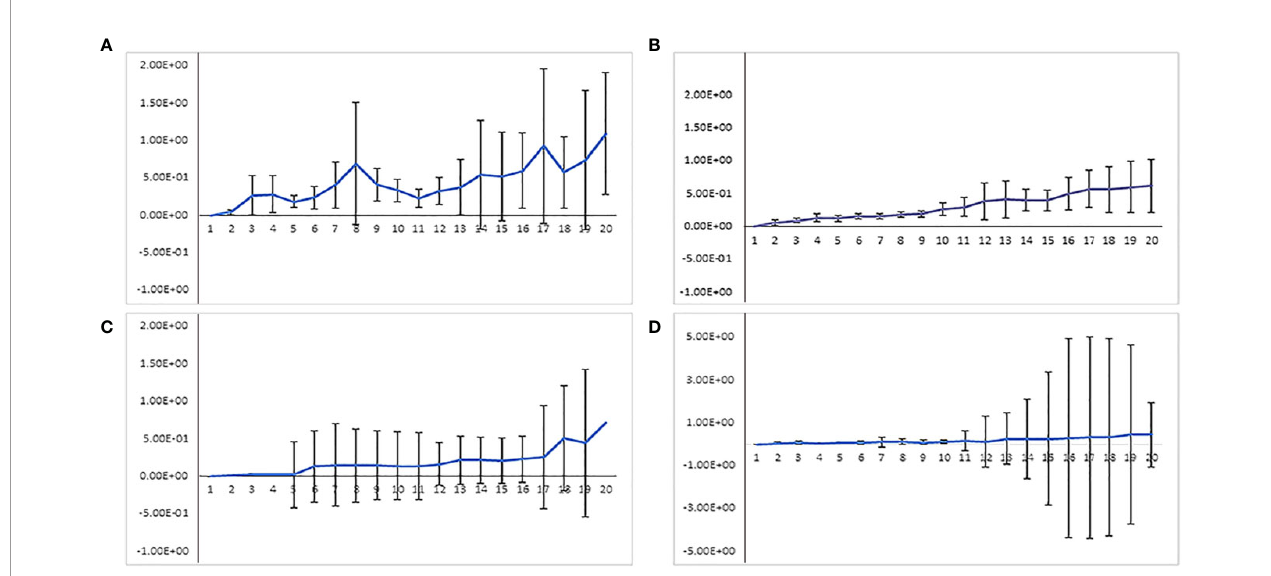
FIGURE 8 | Comparing mean square distance (MSD in µm) of telomeres labeled by indirectly labeled aptamer-dCas9 which were under the control of (A) 35S, (B) RPS5a, or (C) ubiquitin promoters. (D) Directly labeled dCas9, which was under the control of a ubiquitin promoter. Telomeres showed random movements regardless of promoter type and how dCas9 was labeled.